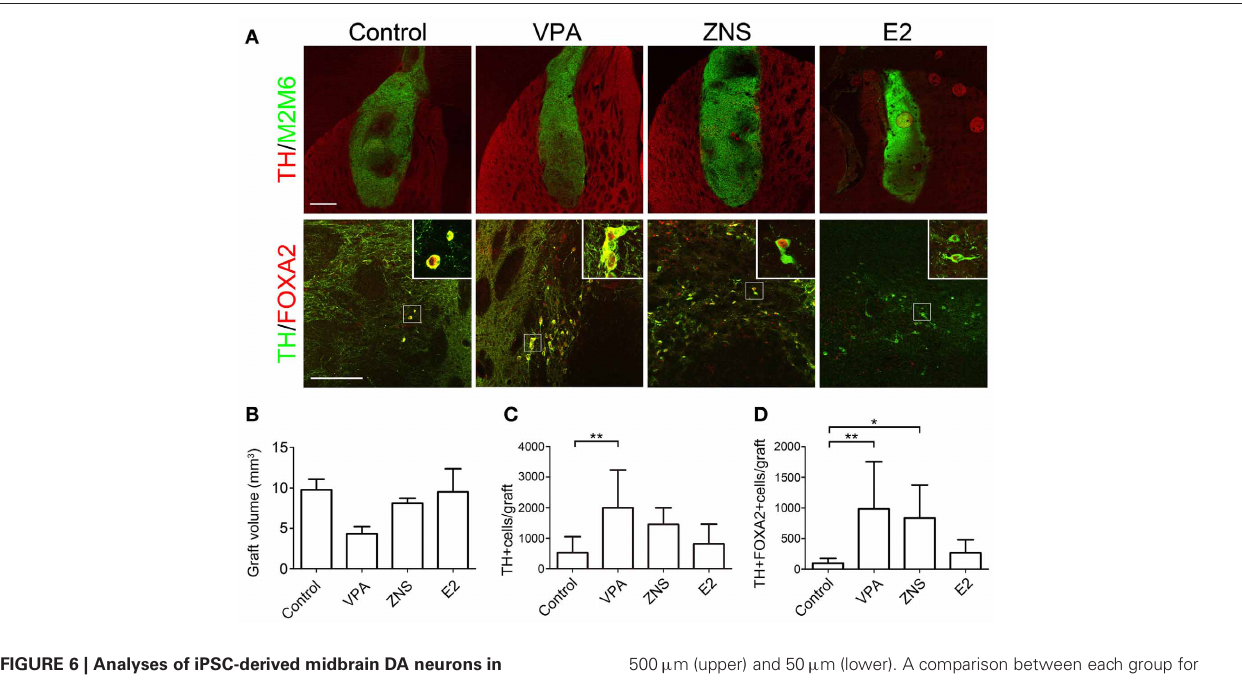
500 µ m (upper) and 50 µ m (lower). A comparison between each group for (B) average graft volume, (C) the number of TH + cells per graft, and (D) the number of TH + FOXA2 + cells(midbrain DA neurons) per graft. The data are presented as the mean ± SD . ( ∗ P < 0 . 05, ∗∗ P < 0 . 01; n = 8 control, n = 6 VPA, ZNS,